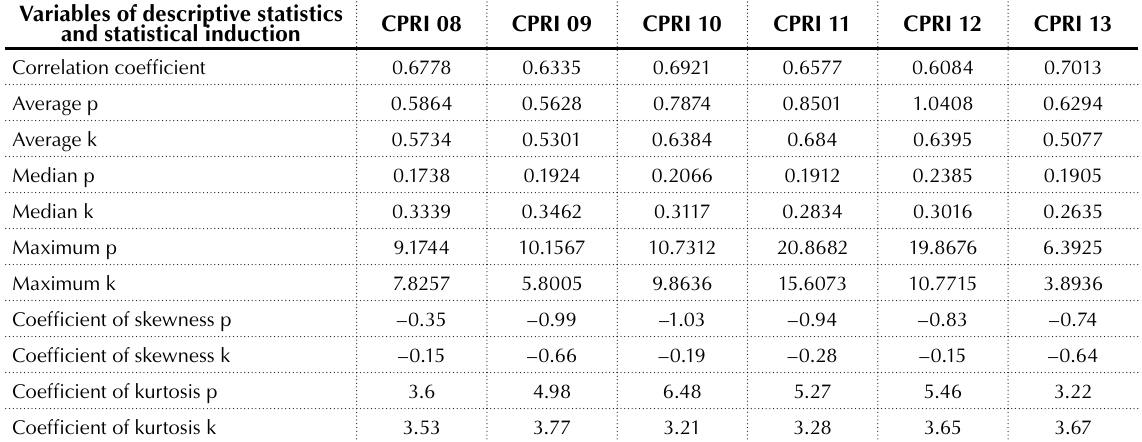
Table 3. Statistical values of cash position ratio indicator (CPRI)